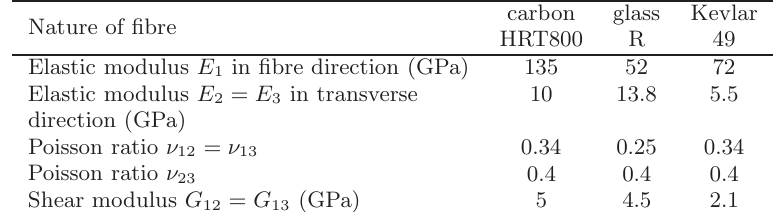
Fig. 2. Definition of the reliability index β and approximation methods FORM/SORM [9]. Table 1. Elastic properties of fibre-reinforced composites (epoxy matrix).